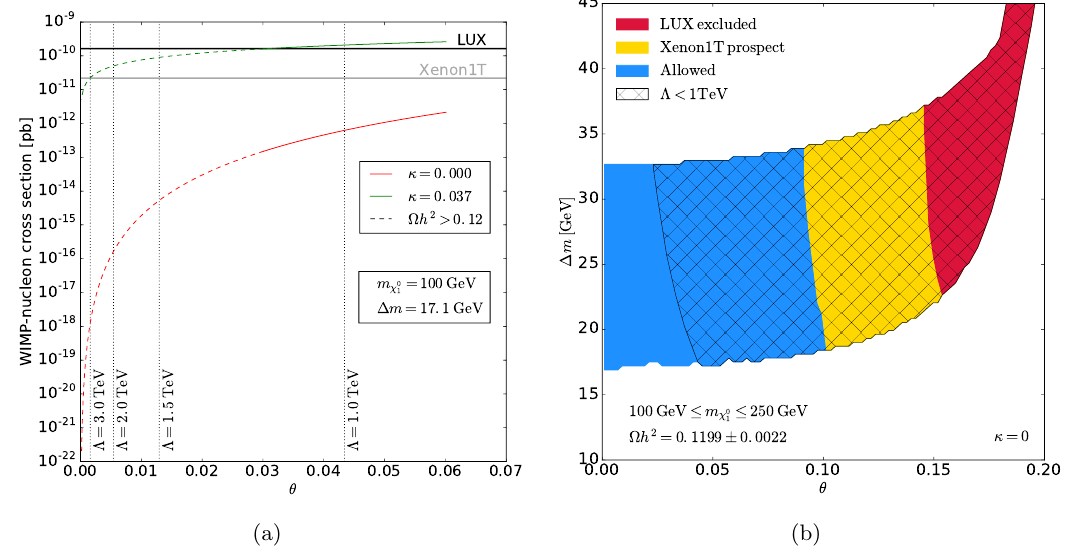
Figure 7 . Same as (cid:12)gure 2 but for the quintuplet model. Left panel: the model is excluded by direct detection for all but small (cid:20) . Right panel: current and projected exclusion bounds at (cid:20) =